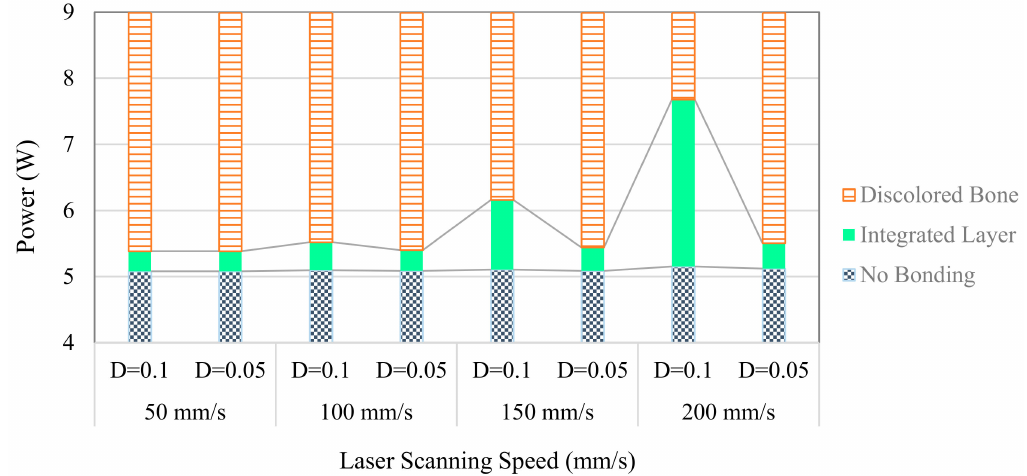
Figure 5. The assessment of the line spacing (D) e ff ect on the DBM / polycaprolactone (PCL) color layer parts. The powder bed distance from the lens is 51 mm with the spot size of 200 µ